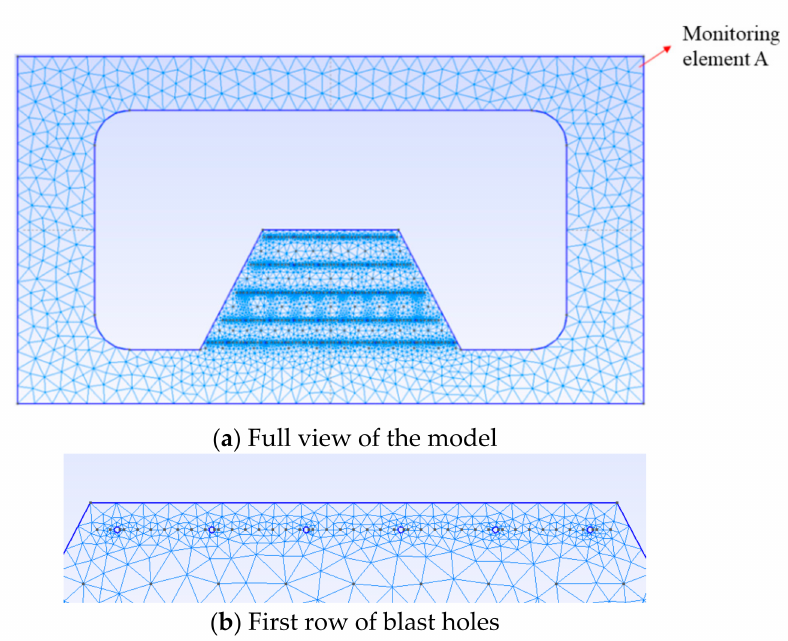
Figure 6. Schematic diagram of tunnel calculation model and monitoring unit for the double-side- drift method.